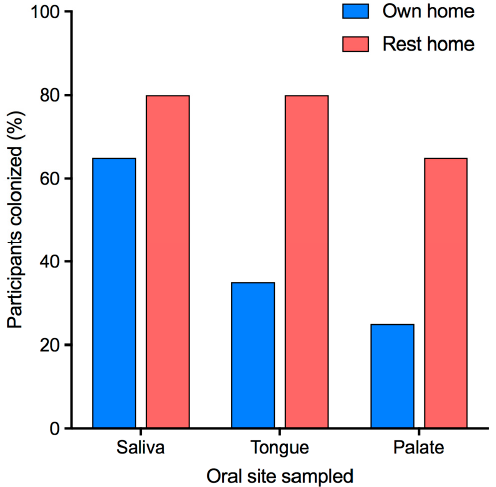
Figure 1. Presence of yeast at oral sites in participants. Percentage of participants colonized by yeast at each oral site.